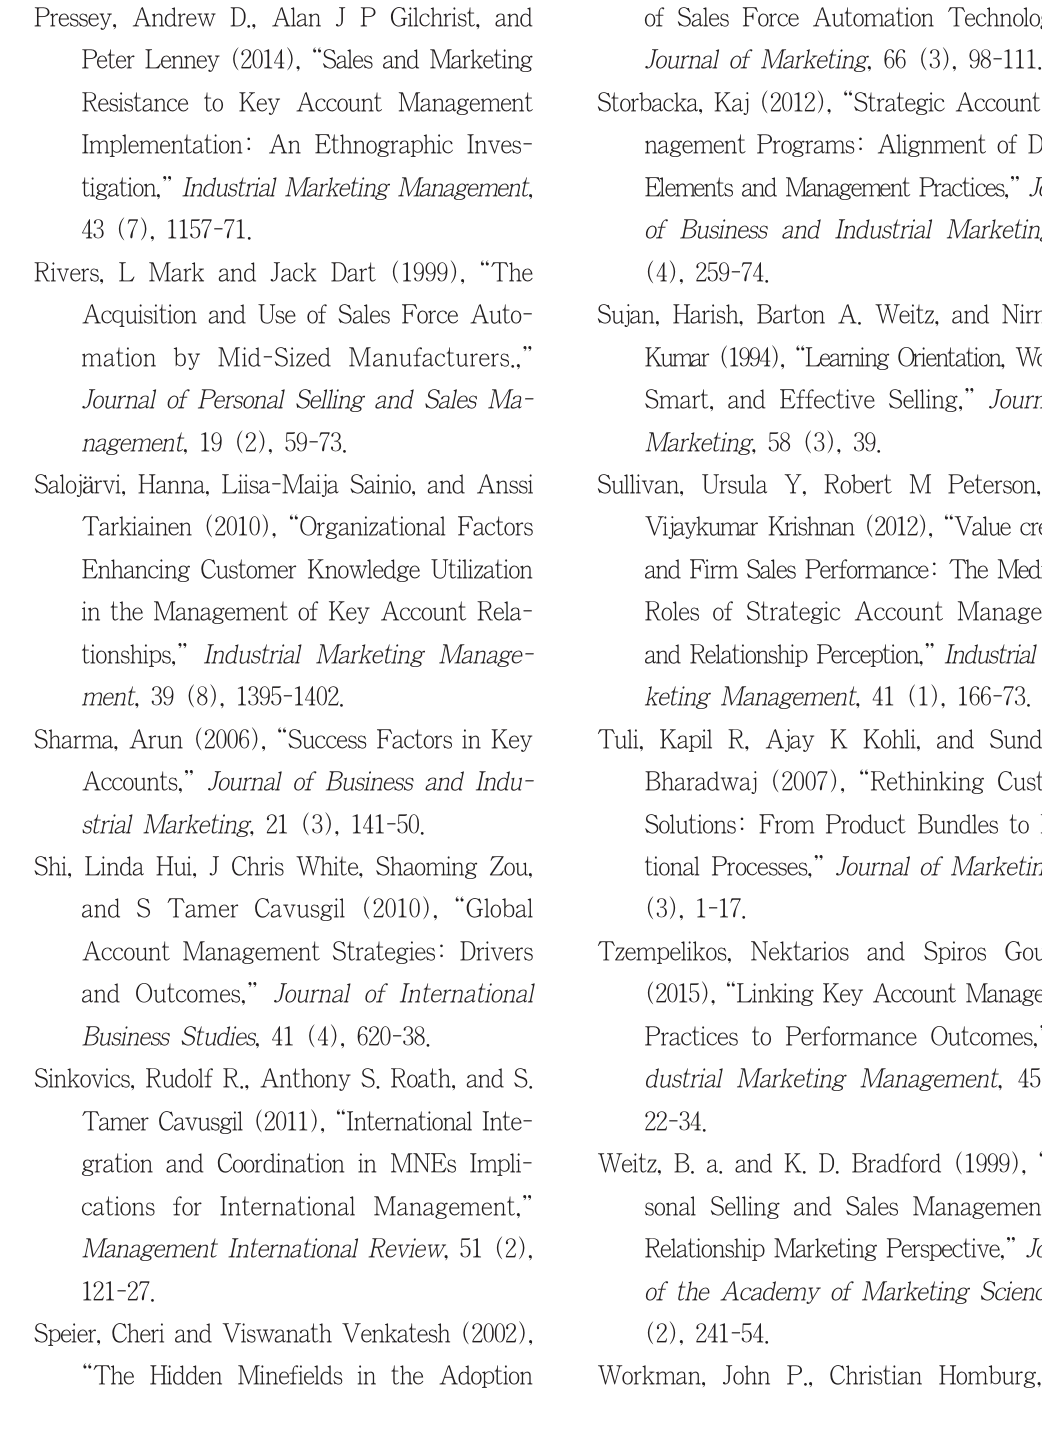
Exploring Factors and Elements of Coordination between Key Account Management Units and Non-key Account Management Units